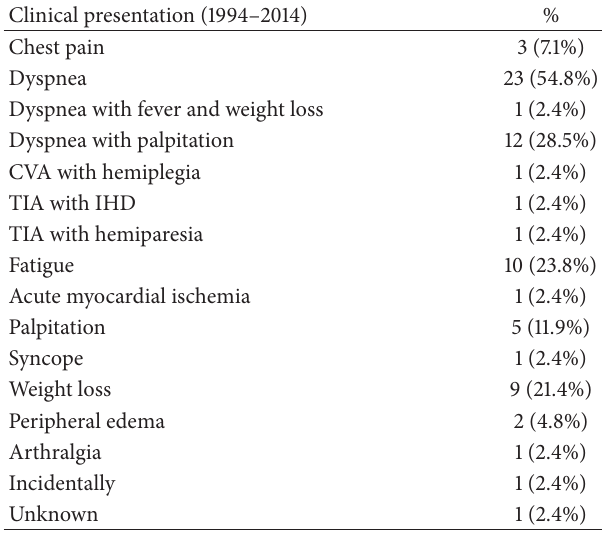
Table 2: Clinical presentation (signs and symptoms) of patents diagnosed with myxoma from 1994 to 2014 in Shahid Modarres